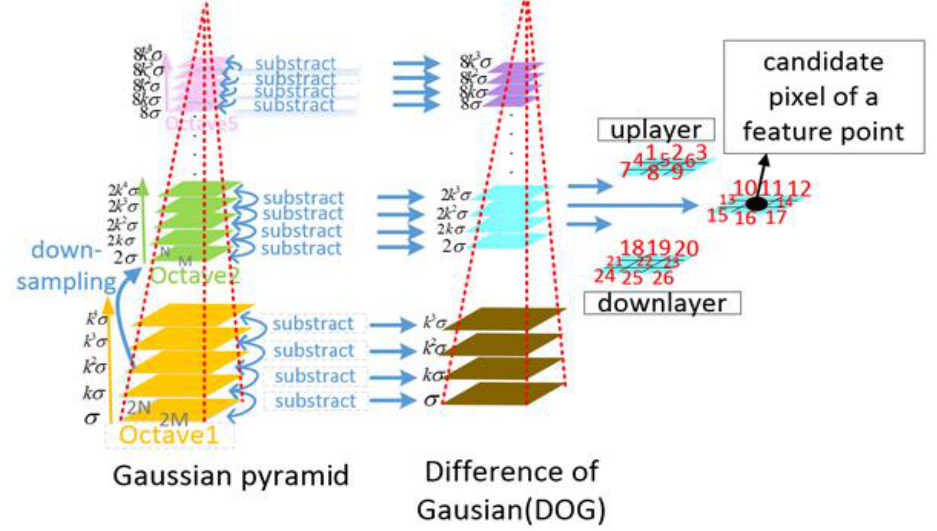
Figure 12. Difference-of-Gaussian (DOG).